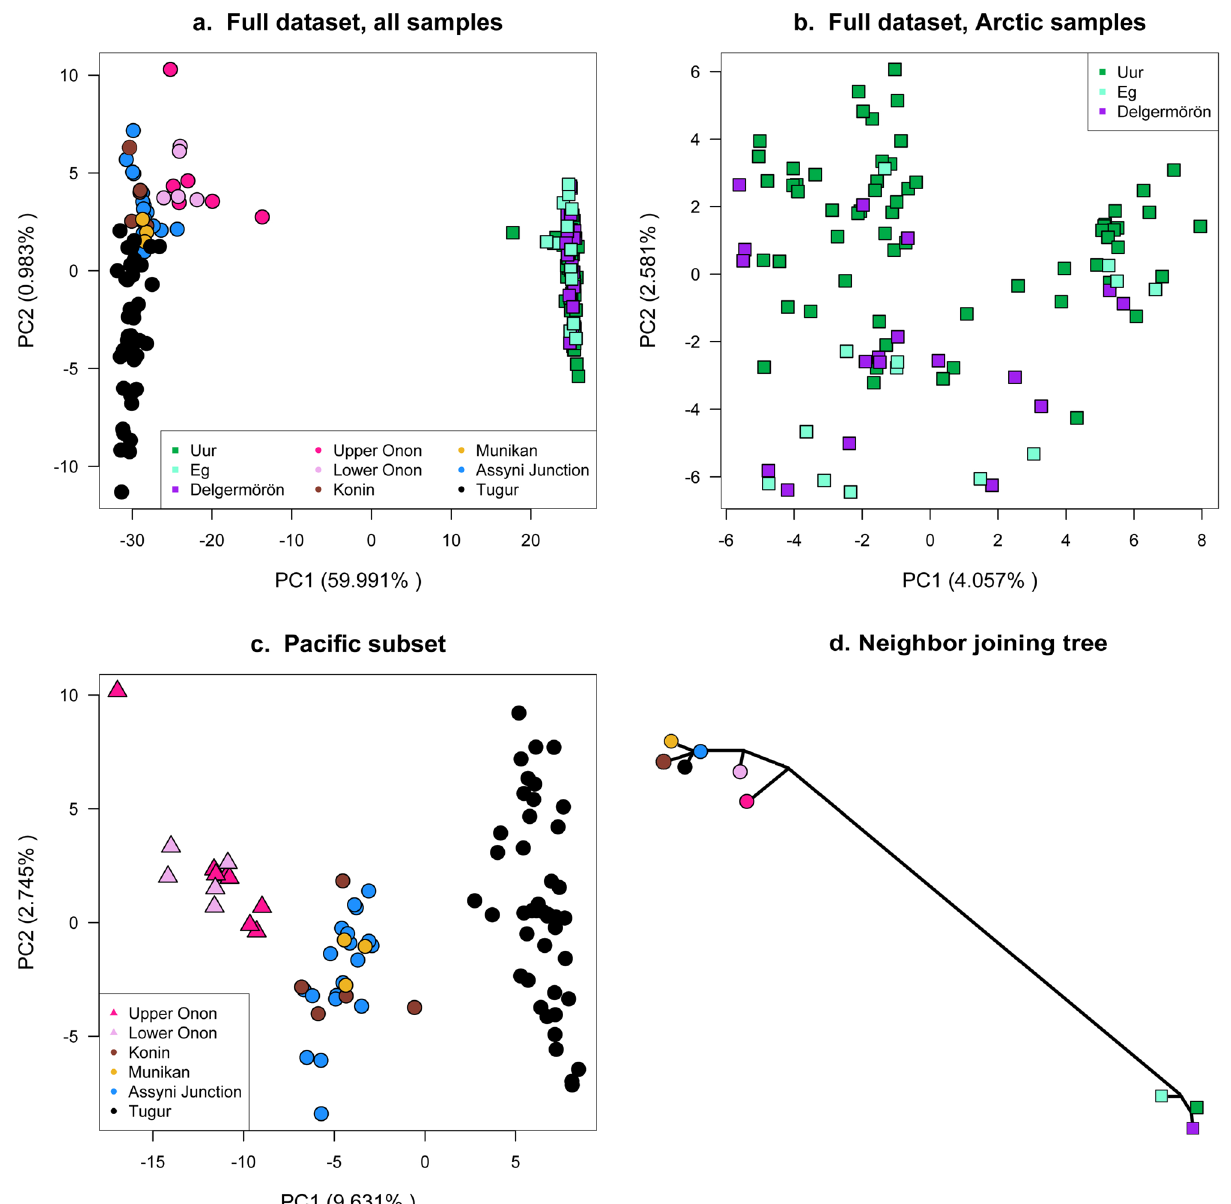
Figure 3. Genetic variation among taimen illustrated with PCA (calculated using R software) of 6046 SNPs called in all sampled individuals ( a ), Arctic individuals ( b ), and in 3961 SNPs called separately for individuals from the Pacific drainages ( c ). In panel ( a ), samples from the Pacific drainages are represented by circles, and those from the Arctic drainage by squares. In panel ( c ), samples from the Amur basin are represented by triangles while those from the Tugur basin are represented by circles. The neighbor joining tree in panel ( d ) supports the deep divergence between Arctic and Pacific drainages, where symbols represent populations shown in panel ( a